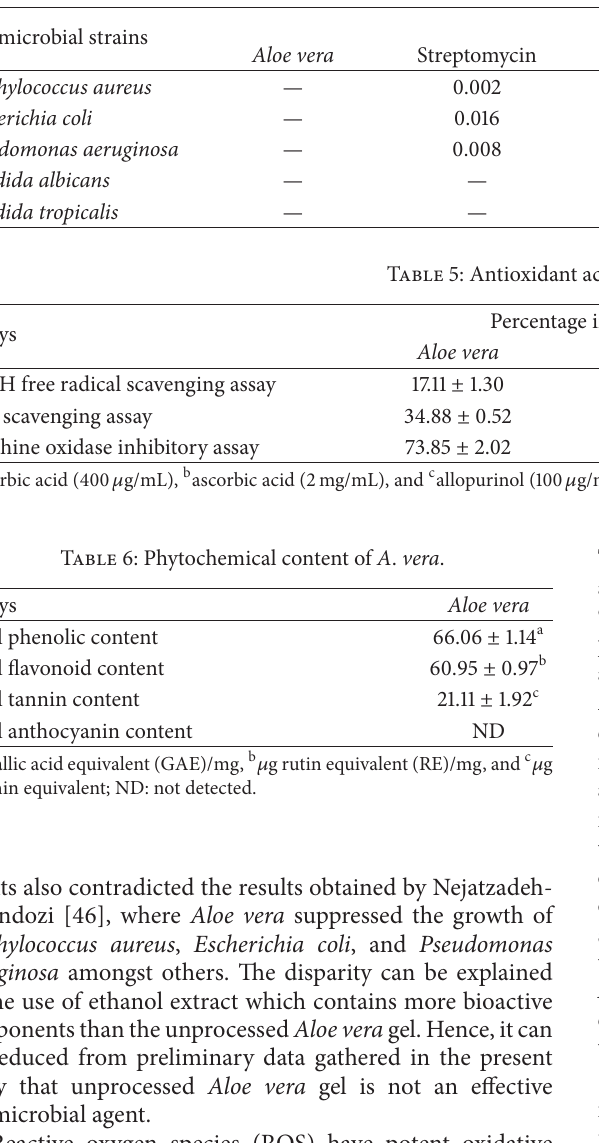
Table 4: Antimicrobial activity of Aloe vera .